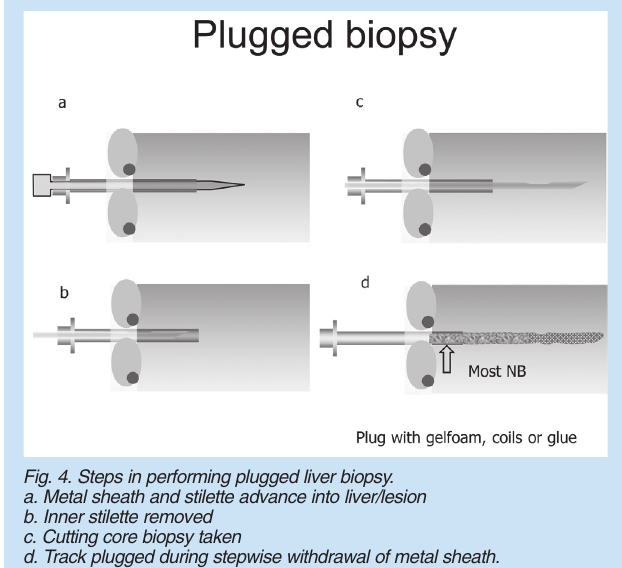
Fig. 4. Steps in performing plugged liver biopsy. a. Metal sheath and stilette advance into liver/lesion b. Inner stilette removed c. Cutting core biopsy taken d. Track plugged during stepwise withdrawal of metal